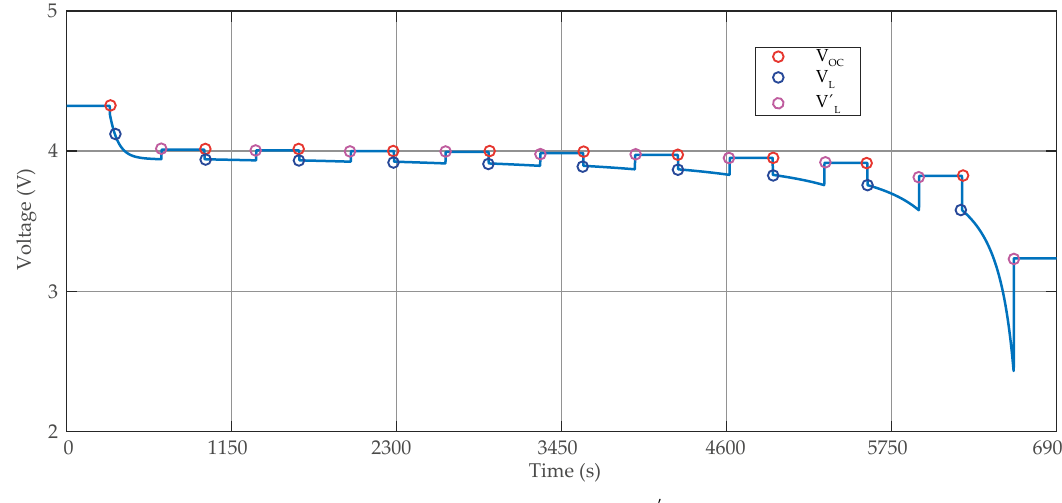
Figure 9. SOC with the V OC , V L and V (cid:48)